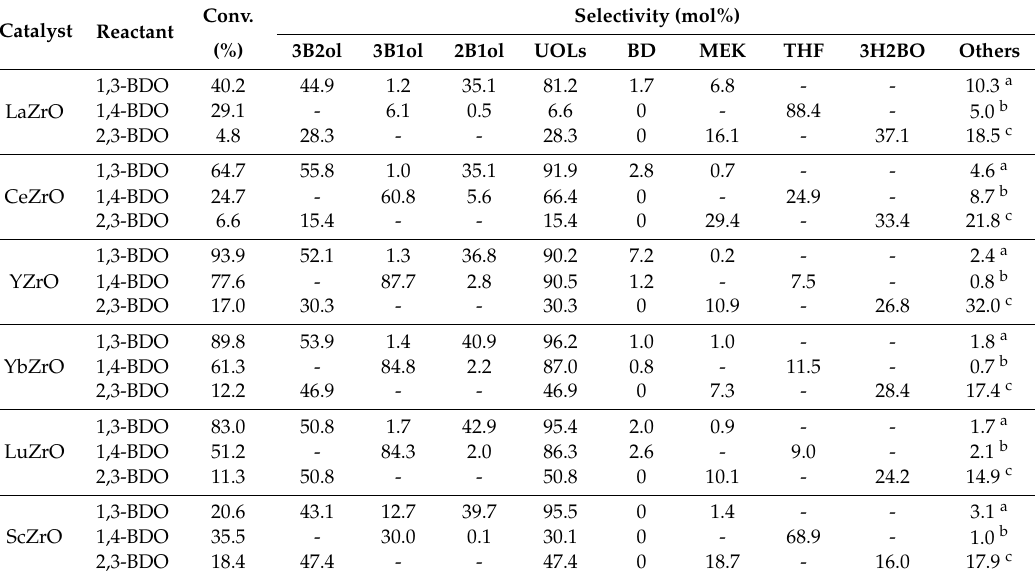
Table 3. Comparison in the dehydration of 1,3-, 1,4- and 2,3-BDO over REZrO calcined at 900 ◦ C. Catalyst Reactant